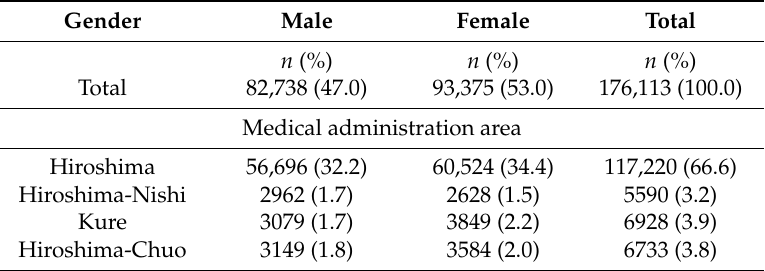
Figure 1. Map of Hiroshima Prefecture by place of living and flow chart of the study population. Hiroshima Prefecture is located in the west of Japan. The prefecture is divided into seven medical administration areas. Subjects living outside of Hiroshima Prefecture were only used for logistic regression analysis. † refers to population density (people per km 2 ). Table 1. General characteristics of the participants.